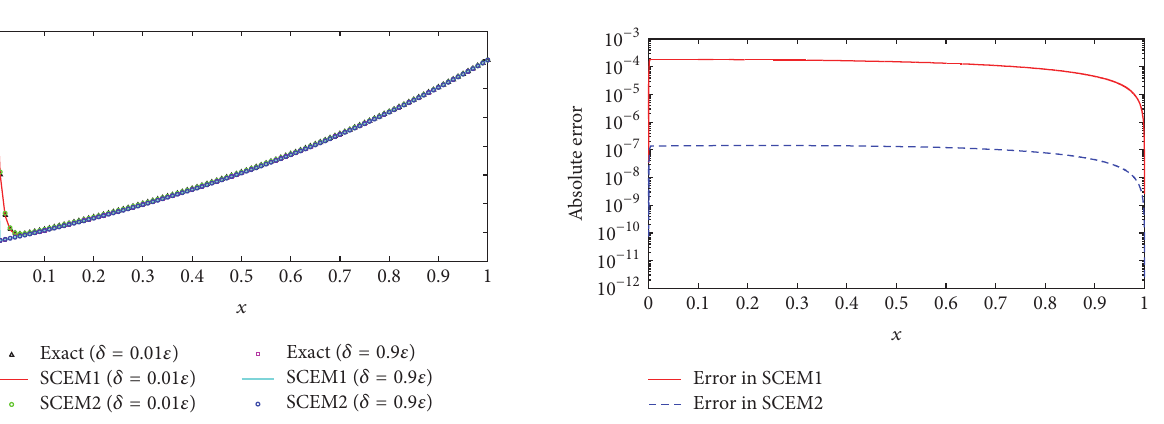
Figure 4: Absolute errors in SCEM approximations for left layer